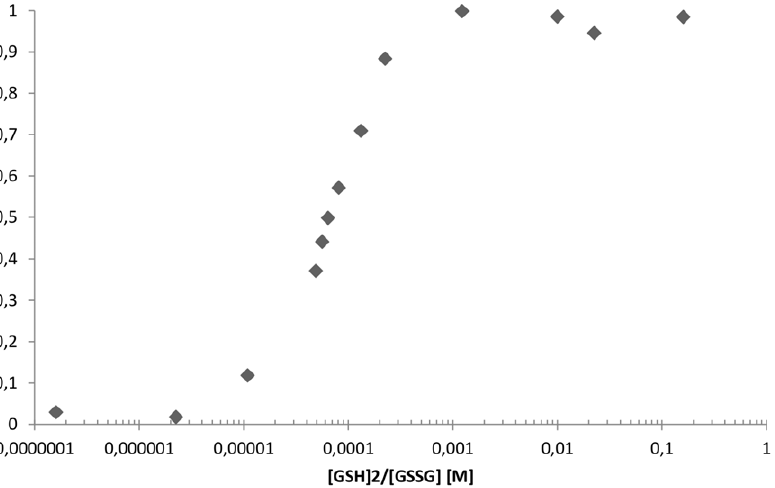
Figure 7. Redox equilibrium of H.pylori HP0231 with glutathione. The fraction of reduced (R) HP0231 was determined using the specific HP0231 fluorescence at 324